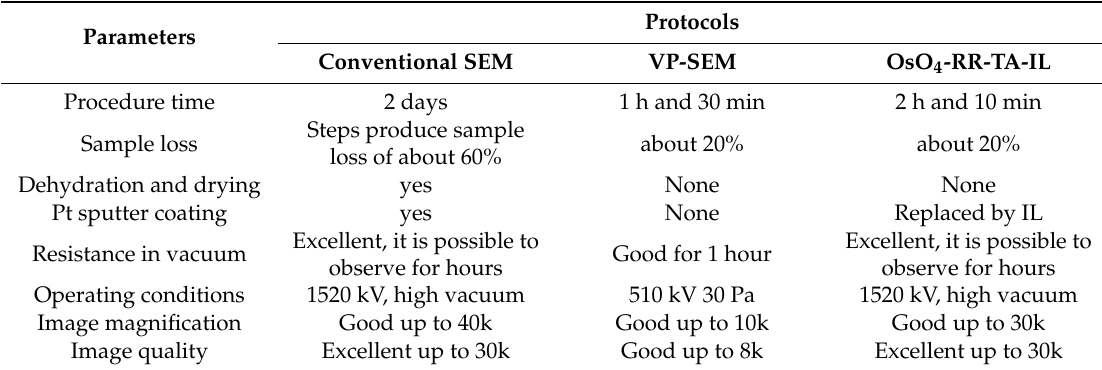
Table 2. Parameters considered in the protocol